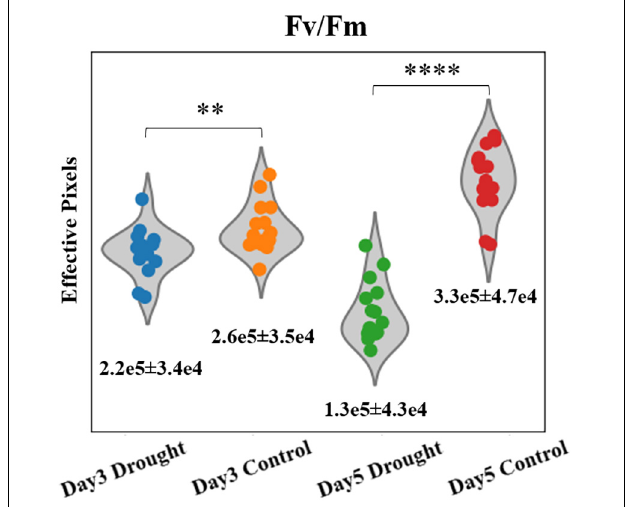
FIGURE 3 | Violin plots of effective pixel numbers of F v /F m images for drought and control plants at days 3 and 5 ( ∗∗ p < 0.01, ∗∗∗∗ p < 0.0001). Mean ± SDs are